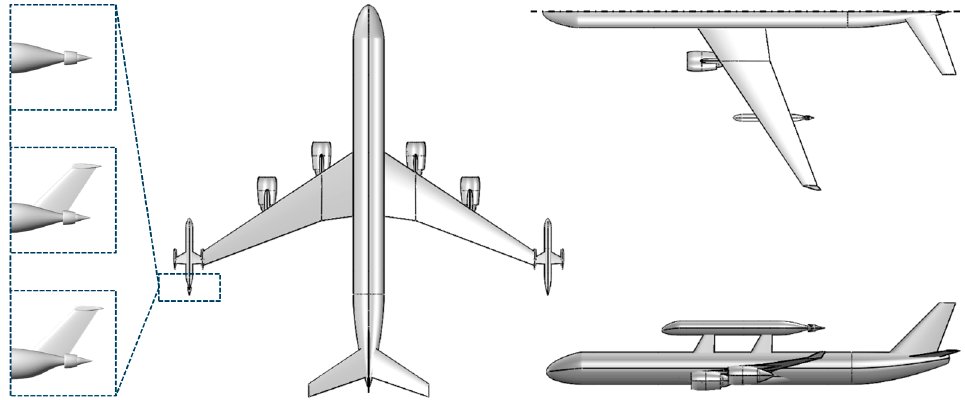
Figure 33. Basic schematic of PFC flying lab similar to the BLADE demonstrator aircraft.